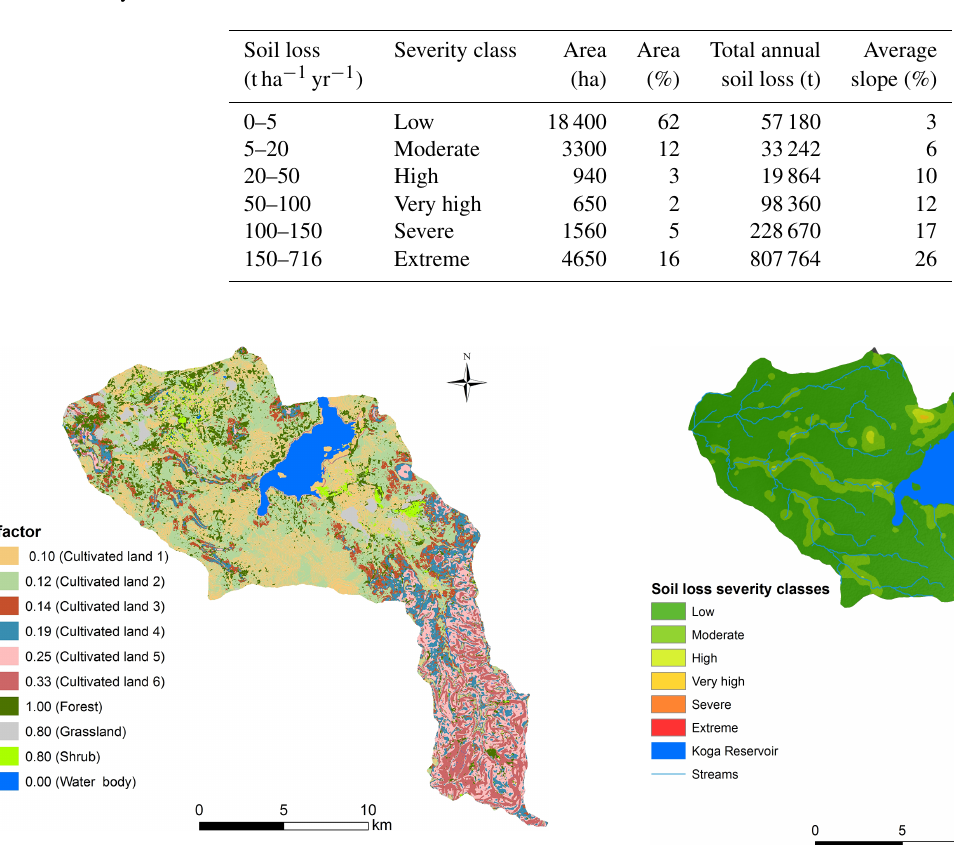
Table 3. Area and amount of annual soil loss for each severity class and the corresponding average slope (%), measured mean LS and R values of the study site.